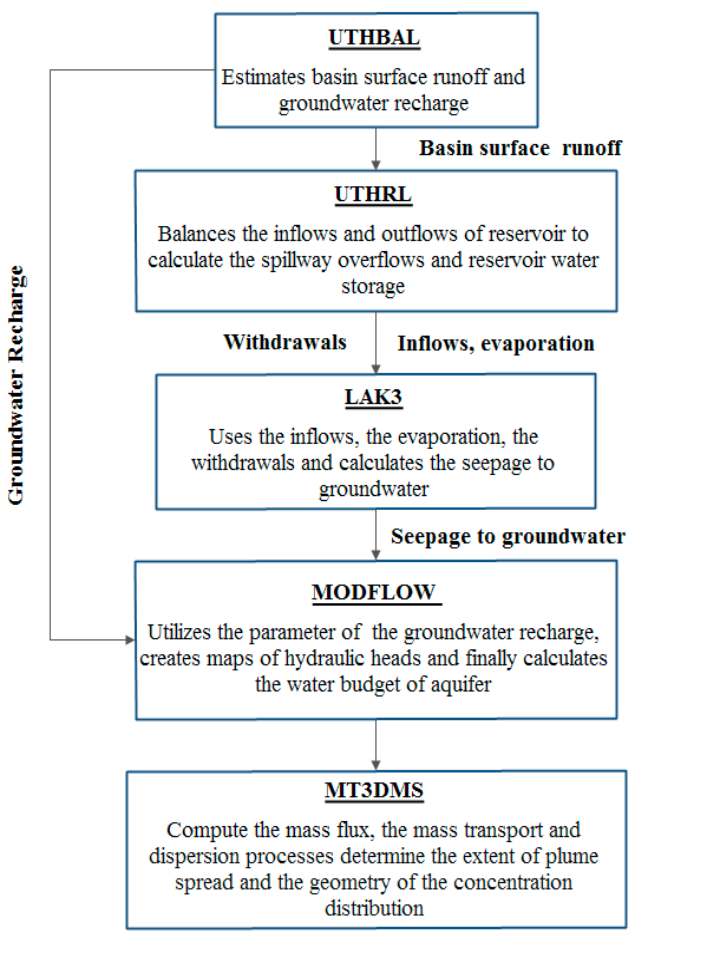
Figure 2. Integrated modeling system of the